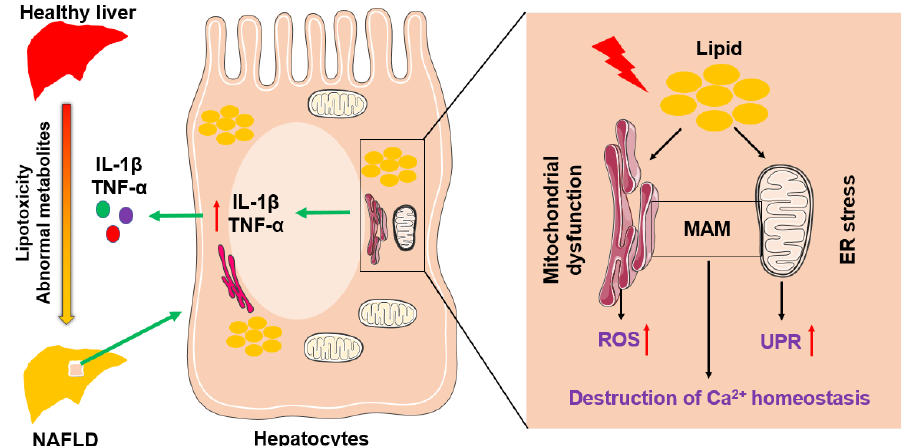
Figure 1. The role of mitochondria and endoplasmic reticulum in NAFLD pathogenesis. Abnormal lipid and glucose metabolism caused by diet and other environmental factors can lead to lipid accumulation in hepatocytes, resulting in liver injury and steatosis. Hepatic lipid accumulation causes mitochondrial dysfunction and ER stress, accompanied by the increase of ROS and the activation of the unfolded protein response. In addition, disruption of the integrity of MAM destroys Ca2+ homeostasis. Above factors adverse liver inflammatory by inducing overexpression of pro-inflammatory cytokines, such as interleukin-1β (IL-1β) and tumor necrosis factor-α